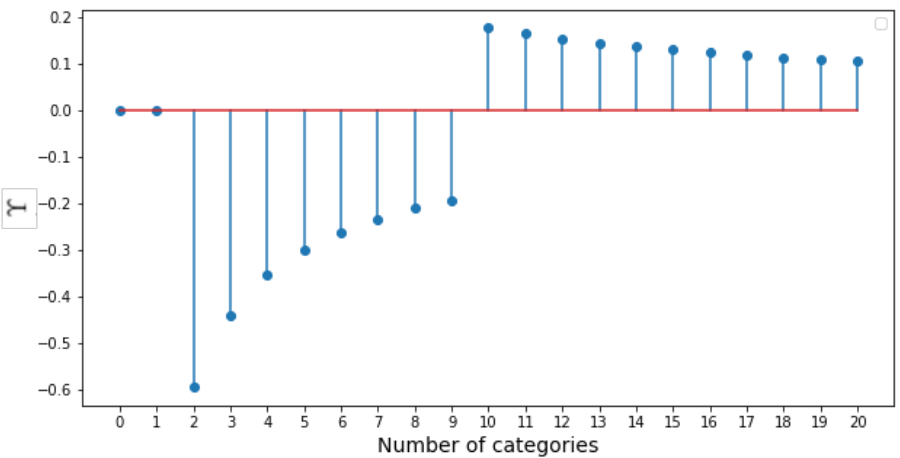
Figure 3. Variation of irrelevance score Υ under maximum imbalance